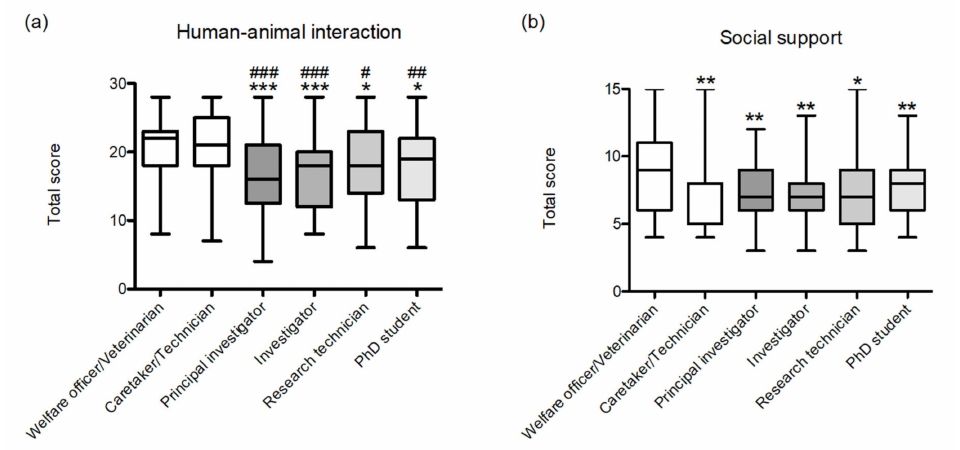
Figure 2. Total score of ( a ) human–animal interaction (max 28) and ( b ) social support by job category (max 15). Data are presented as group median (min to max). * p < 0.005, ** p < 0.01, *** p < 0.001 versus welfare officers and/or veterinarians; # p < 0.05, ## p < 0.01, ### p < 0.001 versus animal-facility caretakers or